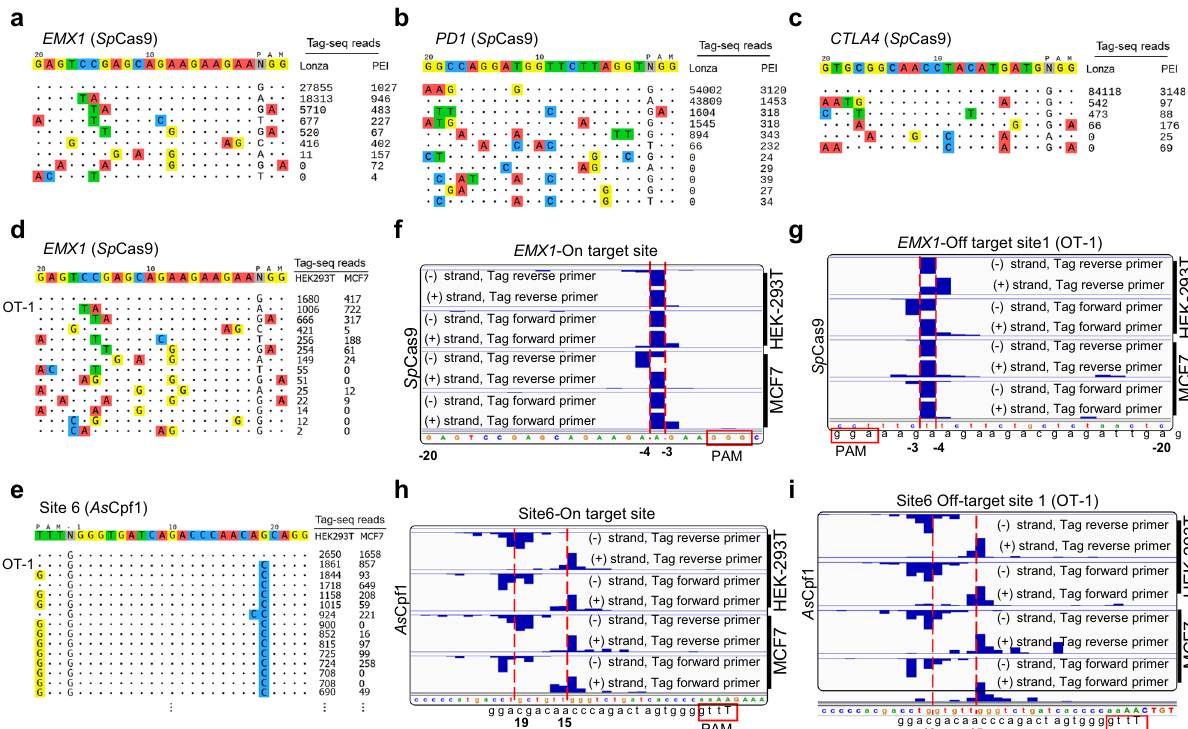
Fig. 2 Tag-seq global pro fi les and molecular characterizes off-target cleavages induced by Cas-nuclease. a – c PEI-based transfection and electroporation (Lonza Nucleofection)-based methods displayed comparable results in detection of off-target sites at EMX1 , PD1, and CLTA4 loci. d , e Off-target sites detection with Tag-seq. Sp Cas9 and As Cpf1 targeting EMX1 and Site 6, respectively, induced off-target cleavages in HEK293T and MCF7 cells. For visualization, the targeted sgRNA was shown in the fi rst line and the on-target and the off-target sites were shown without or with mismatches to the sgRNA sequence by color highlighting. Sequencing read counts were shown to the right of each site. Due to the limited space, the off-target sites for Site 6 were not completed displayed, and a full list was displayed in Supplementary Fig. 3. f – i Tag-seq displayed the characteristics of the Sp Cas9/Cpf1-induced- DSBs. Cutting at 3-4 bp upstream from the NGG PAM site and resulting in 1-bp overhangs at EMX1 on-target ( f ) and off-target site 1 (OT-1) ( g ) sites for Sp Cas9 in both HEK293T and MCF7 cells. Resulting multiple overhangs at Site 6 on-target ( h ) and off-target site 1 (OT-1) ( i ) sites for As Cpf1 in both HEK293T and MCF7 cells. Red dotted lines indicated the cutting